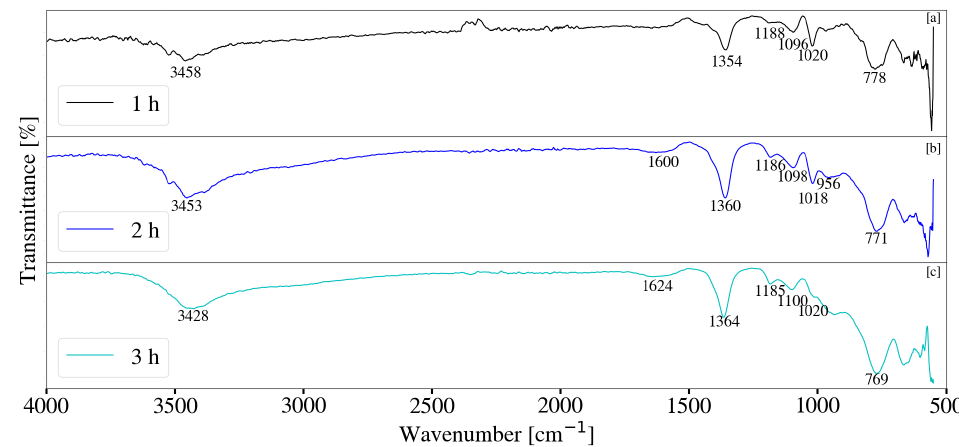
Figure 17. ( a ) FT-IR analysis for Mg-Al LDH sample synthesised for a residence time of 1 h (S10). ( b ) FT-IR analysis for Mg-Al LDH sample synthesised for a residence time of 2 h (S11). ( c ) FT-IR analysis for Mg-Al LDH sample synthesised for a residence time of 3 h (S12). Milling parameters were set at a rotational speed of 2000 rpm, jacket water inlet temperature of 50 °C, media size of 2 mm and a solids loading of